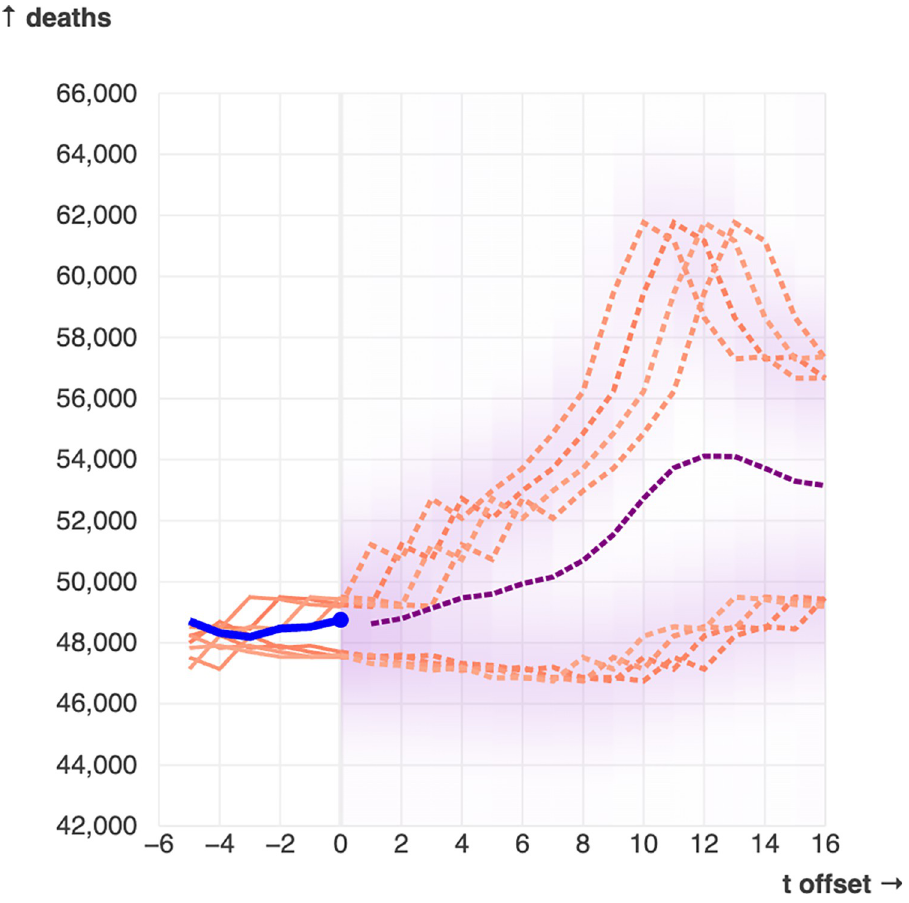
Fig 2. This snapshot of the tool (using the default mortality data and with time point t = 87 selected) shows an example where point forecasts (the dashed purple line) are an ineffective summary of the forecasting results. The forecasting method appears to identify two potential futures, one in which the number of deaths will rise to peak and then begin to decrease, and another in which the number of deaths decreases slowly before beginning to rise. In this case, point forecasts will fall between these two futures, meaning information about the two possibilities is lost in favor of a summary which is not representative of the method’s more nuanced results. That nuance can be preserved by representing all neighbors’ futures together, but that could become visually overwhelming with a larger number of neighbors or in more complex cases. We instead propose the shaded forecast area (the purple gradients in the forecast horizon) as a compromise. The shaded forecast area uses gaussian kernels to present a more detailed summary of the neighbors’ futures than the point forecasts, while combining similar trajectories for the sake of visual